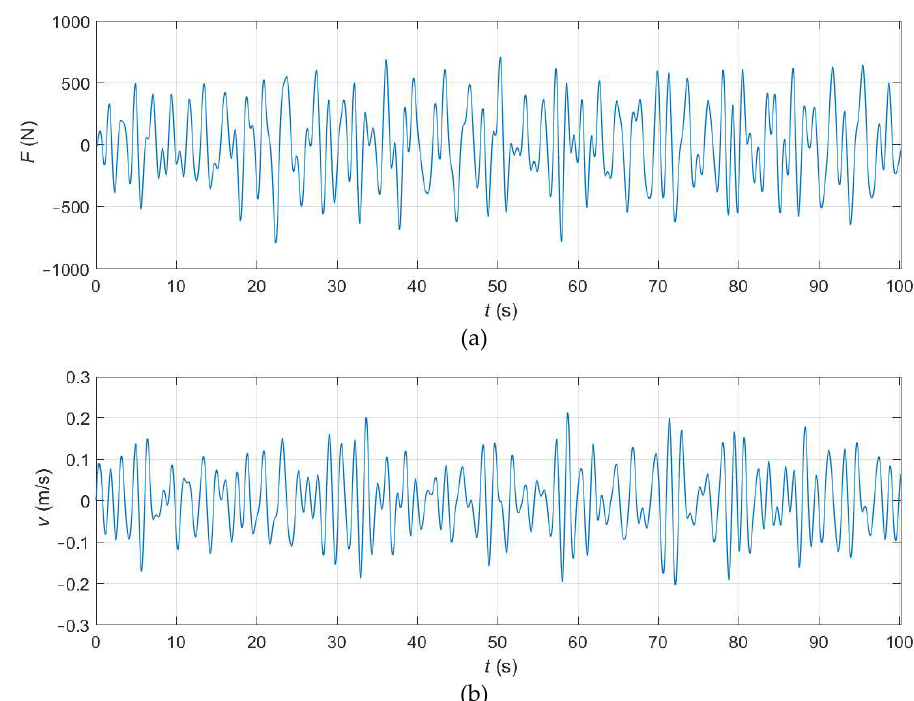
Figure 7. Numerical time series of the: ( a ) force input; ( b ) heave velocity response.